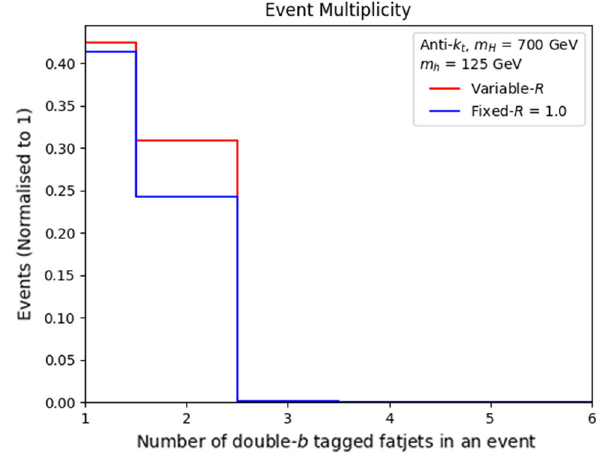
Fig. 5 The double b -tagged fat jets multiplicity distribution for our